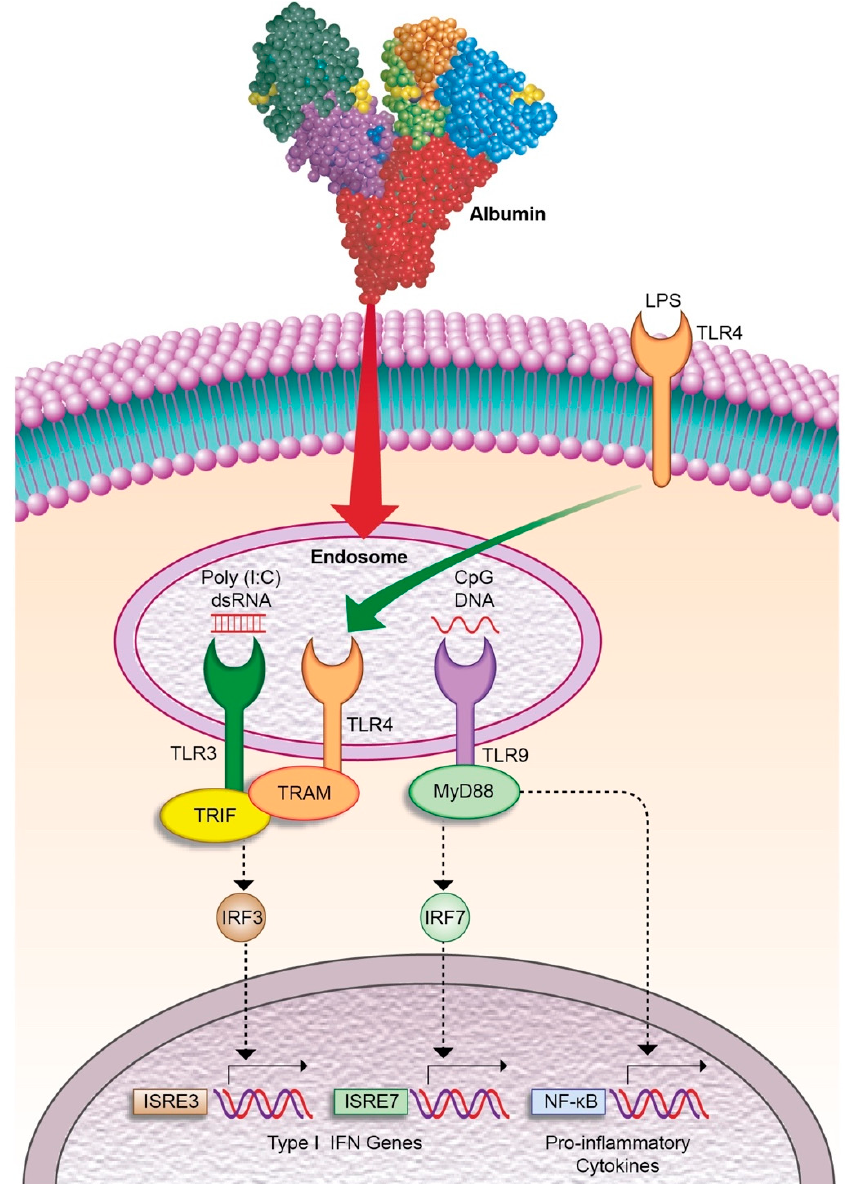
Figure 2. Human serum albumin (HSA) exerts immunomodulatory effects in leukocytes by blocking Toll-like receptor (TLR) signaling pathways in the endosomal compartment. HSA is internalized by leukocytes and in the endosomes inhibits inflammatory cytokine production induced by bacterial single-strand CpG-DNA, which binds to its cognate receptor TLR9 and triggers the signaling by recruitment of myeloid differentiation primary response gene 88 (MyD88). HSA also inhibits other endosomal TLRs such as TLR3, which is activated by double-strand RNA (i.e., poly (I:C)) and TLR4, which, after binding to LPS, translocates to the endosome. Both TRL3 and TLR4 signal via TIR-domain-containing adapter-inducing interferon- β (TRIF), which mediates type I interferon (IFN) responses.